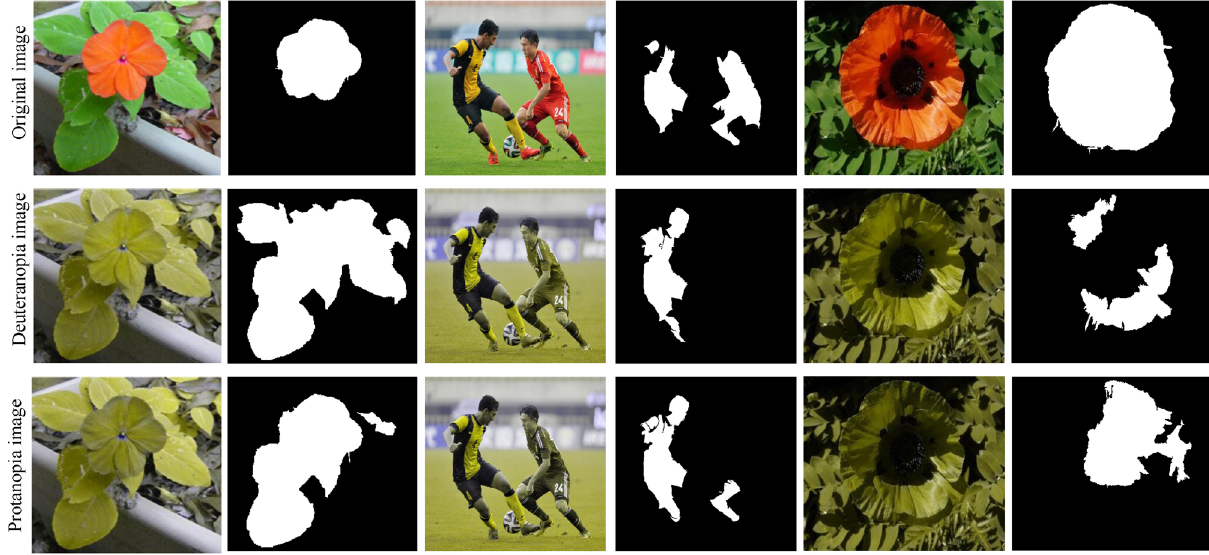
Fig. 3 Examples of saliency detection in standard images, red-blind simulated images, and green-blind